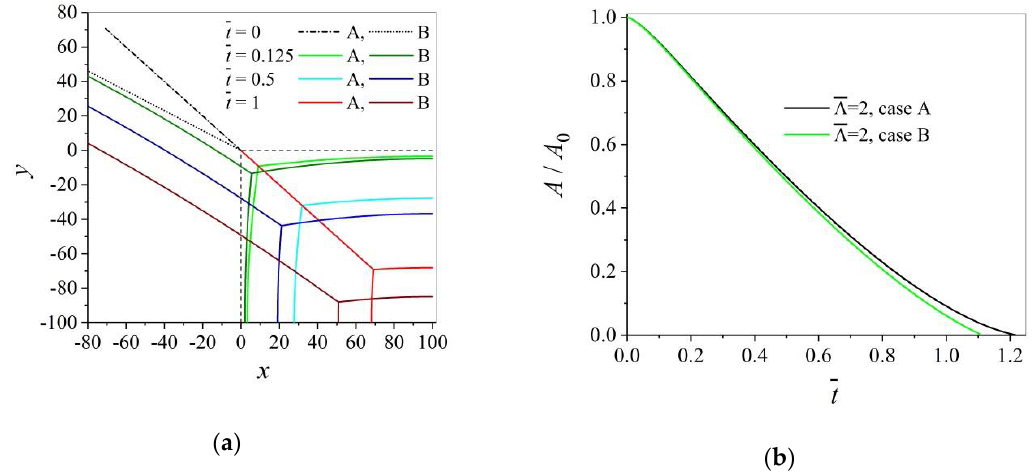
Figure 16. The arrangement is described by a “unit - cell” consisting of the highlighted triple point and the adjacent grain boundaries. ( a ) Grain arrangement A: Surface tessellated by alternating squares and octagons. ( b ) Grain arrangement B: Squares are surrounded by hexagons and dodecagons.